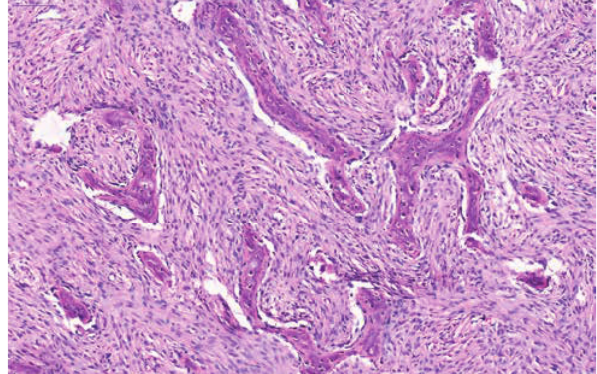
Figure 6: Microscopic finding of fibrous dysplasia (HE, 400x) – Irregular-shaped trabeculae of bone (like Chinese script) and fibrous connective tissue between